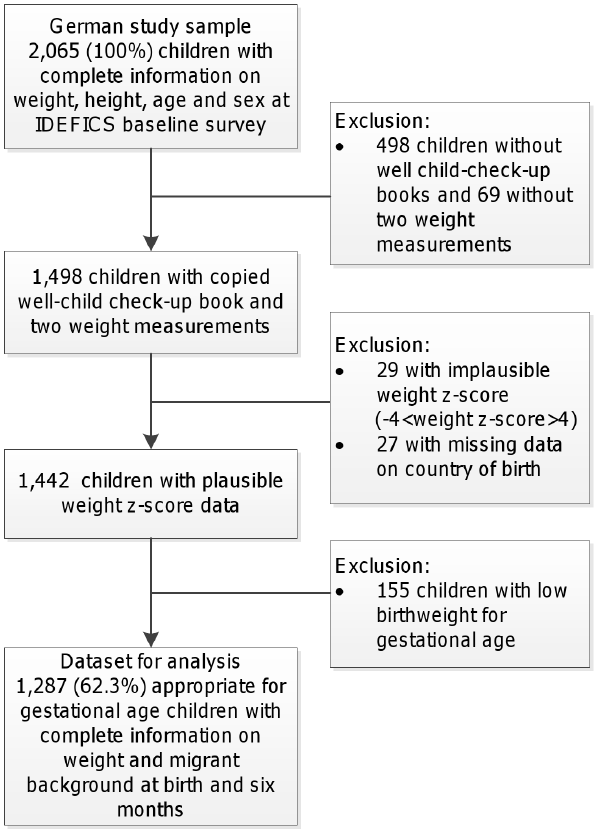
Figure 1. Flow chart describing the exclusion criteria and number of children excluded from